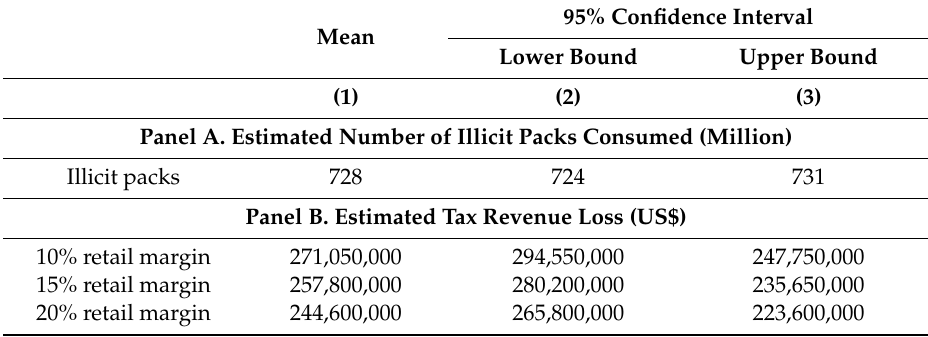
Table 5. Estimated Tax Revenue Loss Caused by Illicit Cigarette Trade in